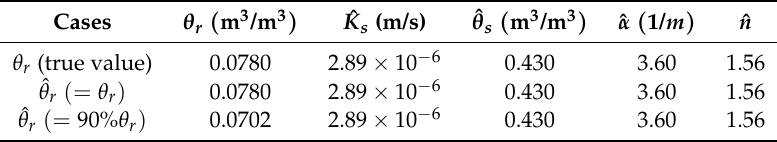
Figure 5. Trajectories of estimated parameters using MHE, EKF and EnKF, compared with their actual values. Table 4. Comparison of estimated parameters using MHE with their true values, when θ r is assumed to be accurate and 10%